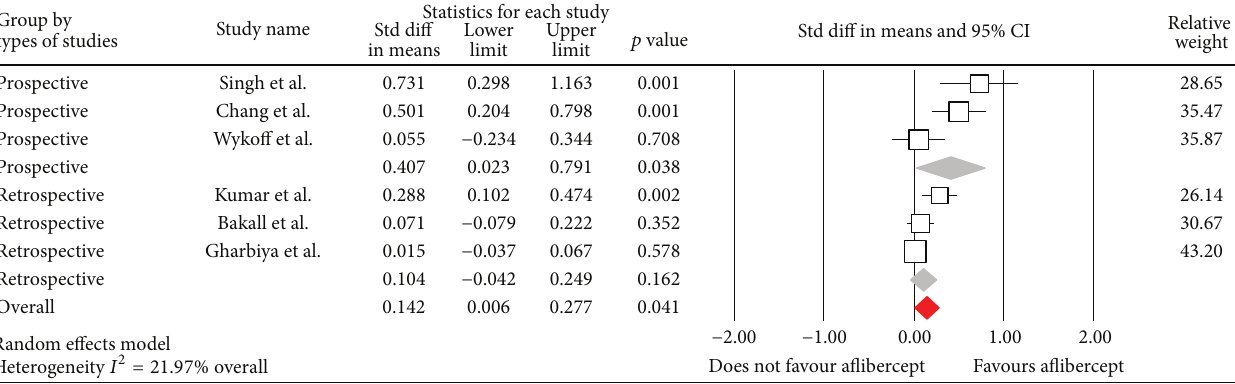
Figure 2: Forrest plot of six studies reporting comparative results of best corrected visual acuity six months after switching to aflibercept. Note that for the prospective studies the accumulated effect demonstrated a significant improvement, which was not found for the retrospective studies. The overall effect was found to be significant ( 𝑝 = 0.04 ). The lower and upper limits represent the 95% confidence interval. Statistics for each study